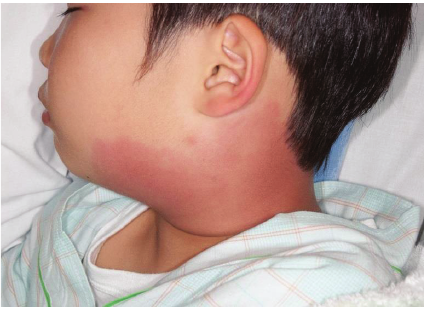
Figure 1: A photograph showing wide spreading left cervical ery- thema and lymph node swelling.